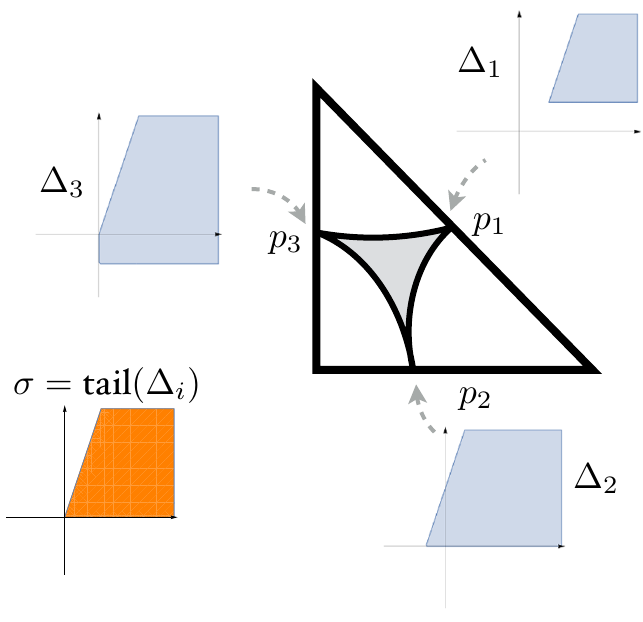
Figure 1. The base B and its associated polytopes for our example